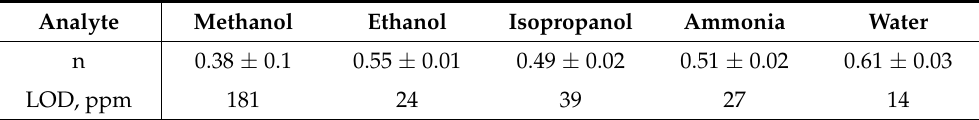
Table 3. The characteristics of Ti 0.2 V 1.8 C MXene-based sensor versus volatile test analytes: power index, n , characterizing S~C n fitting of experimentally observed chemiresistive response and calculated limit of detection (LOD).